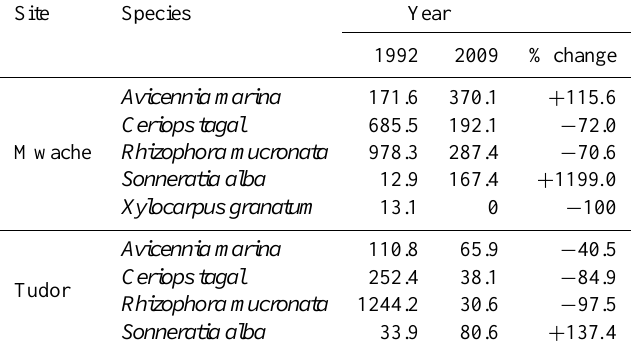
Table 5. Species cover change in 1992 and their shift in